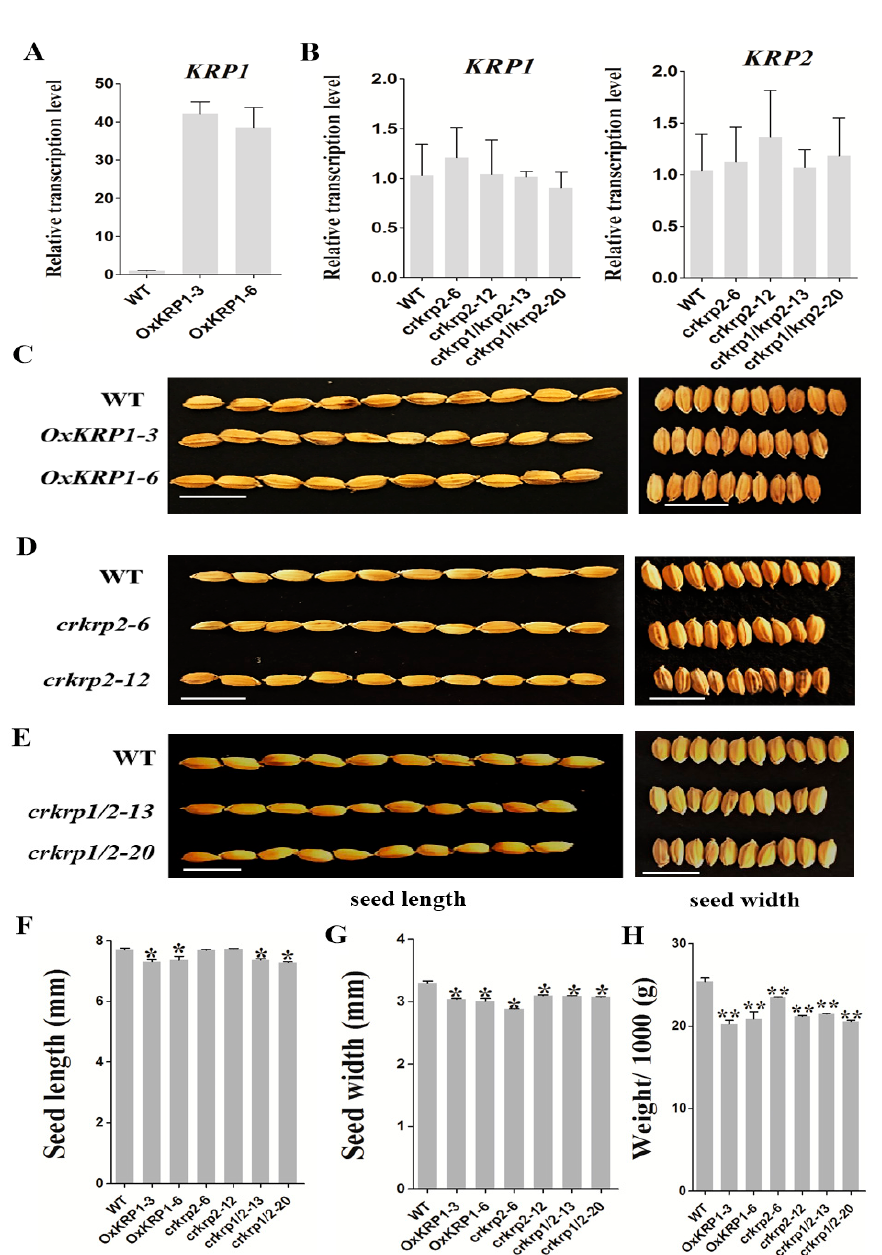
Figure 2. Phenotypic characteristics of OxKRP1 , crkrp2 , and crkrp1/2 mature seeds. ( A ) qRT-PCR analysis for transcript accumulation of KRP1 in the 6 DAP developing seeds of OxKRP1 transgenic lines. Error bars indicate the SD with biological triplicates ( n = 3); ( B ) qRT-PCR analysis for transcript accumulation of KRP1 and KRP2 in the 6 DAP developing seeds of crkrp2 and crkrp1/2 mutants. Error bars indicate the SD with biological triplicates ( n = 3); ( C ) comparison of mature seeds of the WT and OxKRP1 plants. OxKRP1-3 and OxKRP1-6 represent two independent KRP1 -overexpressing lines, respectively; and ( D ) comparison of mature seeds of the WT and crkrp2 plants. crkrp2-6 and crkrp2-12 represent two independent crkrp2 mutants, respectively; ( E ) comparison of mature seeds of the WT and crkrp1/2 plants. crkrp1/2-13 and crkrp1/2-20 represent two independent crkrp1/2 double mutants, respectively; ( F – H ) seed length, seed width and 1000-seed weight of the WT, OxKRP1 , crkrp2 , and crkrp1/2 mature seeds. Error bars indicate the SD with 50 biological replicates ( n = 50). Asterisks indicate the significant difference between the WT and transgenic lines, as determined by Student’s t -test analysis: * p < 0.05, ** p < 0.01. WT: wild type, Bar = 1 cm in ( C – E ).